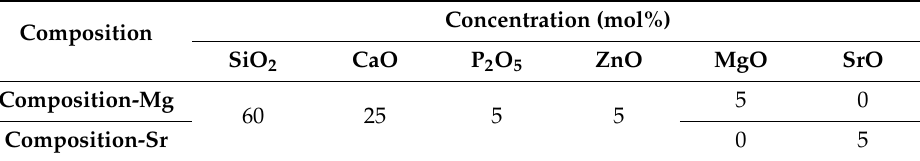
Table 1. Oxide composition of the designed